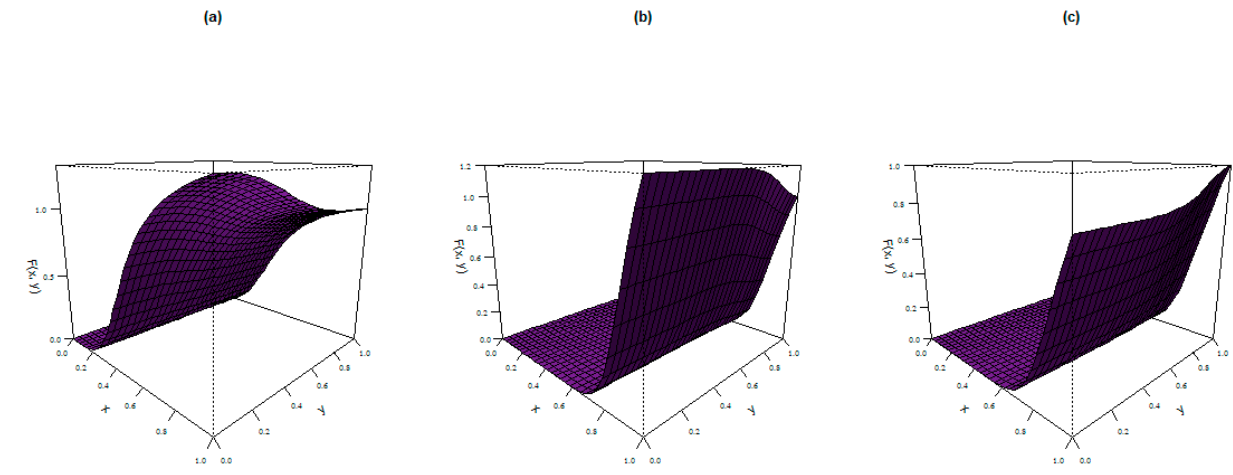
Figure 5. CDF plots of the BAP distribution. The PDF of the BAP distribution is given by